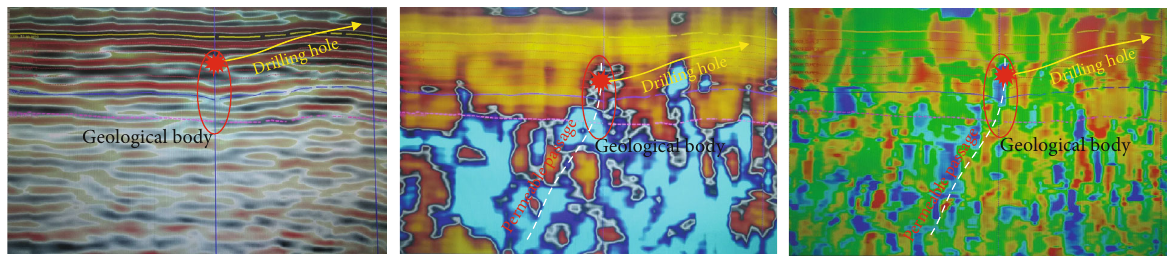
Figure 2: Seismic multiattribute analysis